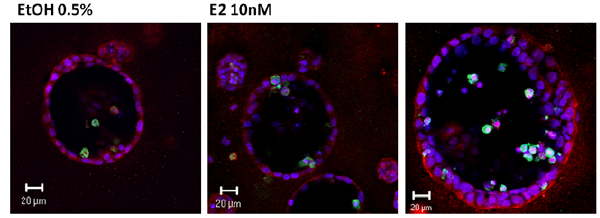
Figure 2. Confocal images of 3D cultures of epithelial breast MCF-10A cells grown in Matrigel for 16 days. Samples were either treated with solvent (ethanol 0.5%) or with 10 nM E2. Obtained structures were stained with antibody against laminin V (red) to stain the basement membrane, antibody against activated caspase-3 (green) to identify apoptotic cells and counterstained with To-PRO 3 to visualize cell nuclei (blue). Cross-sections of solvent control structures show a well delineated spheroid with a layer of viable cells in contact with the basement membrane. Two apoptotic cells are seen in the centre of the acini. A is representative of structures that were unaffected by estrogen treatment, as formed structures resemble those obtained in controls. B depicts acini that showed mild disruption after E2 treatment. Images are representative of 3 independent experiments.